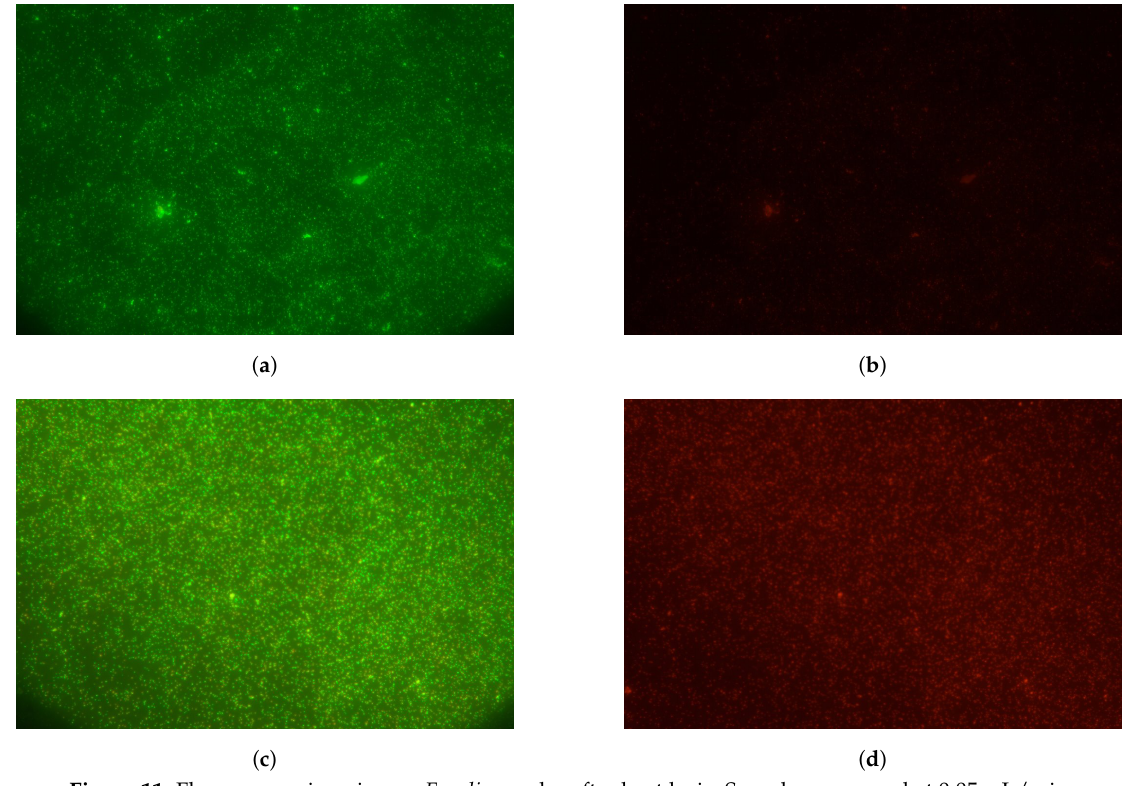
Figure 11. Fluorescence imaging on E. coli samples after heat lysis. Samples processed at 0.05mL/min and heater powered at PWM 60%, acridine orage emission ( a ) and propidium iodide ( b ); and samples processed at 0.02mL/min and heater powered at PWM 80%, acridine orage emission ( c ) and propidium iodide ( d